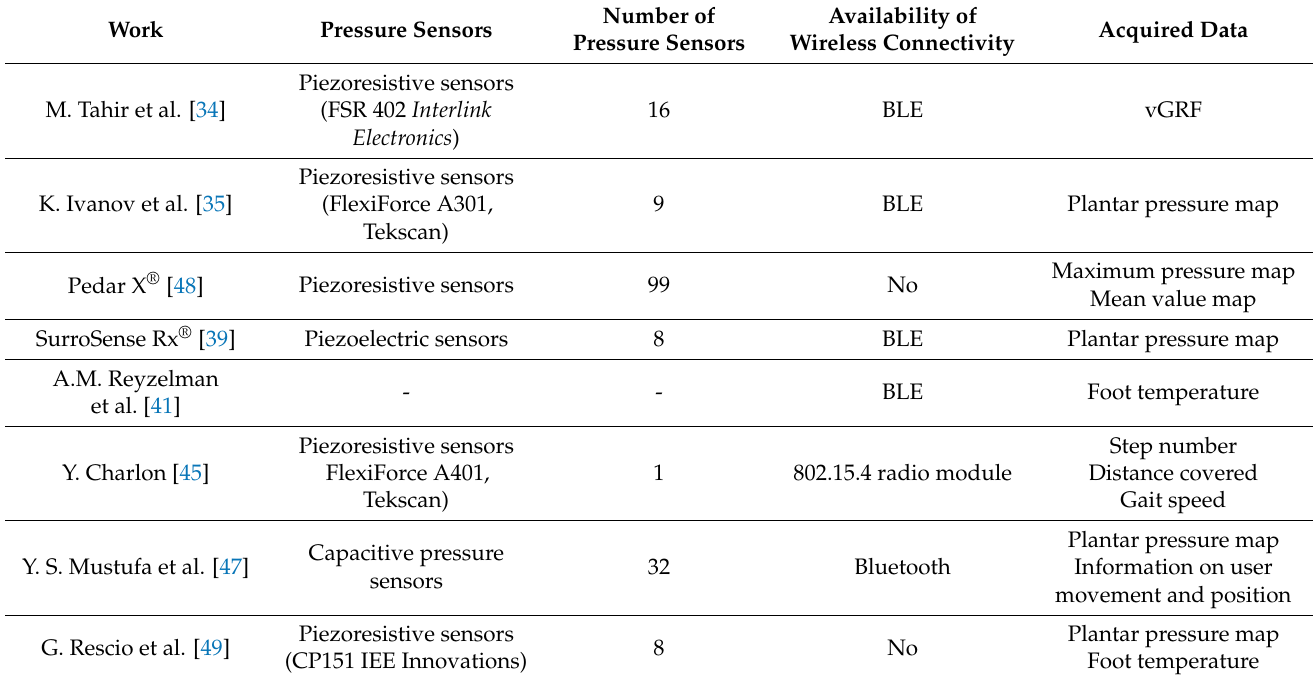
Table 1. Summarizing table with compared smart insoles previously discussed in terms of typology and number of pressure sensors, the availability of wireless connectivity, and acquired